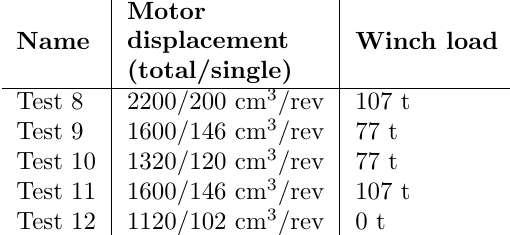
Table 5: Evaluated test